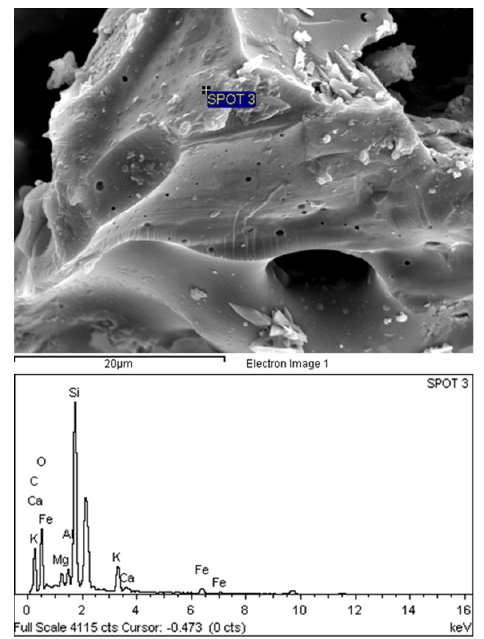
Figure 9. Presence of micro-pores within internal POC aggregate structure.